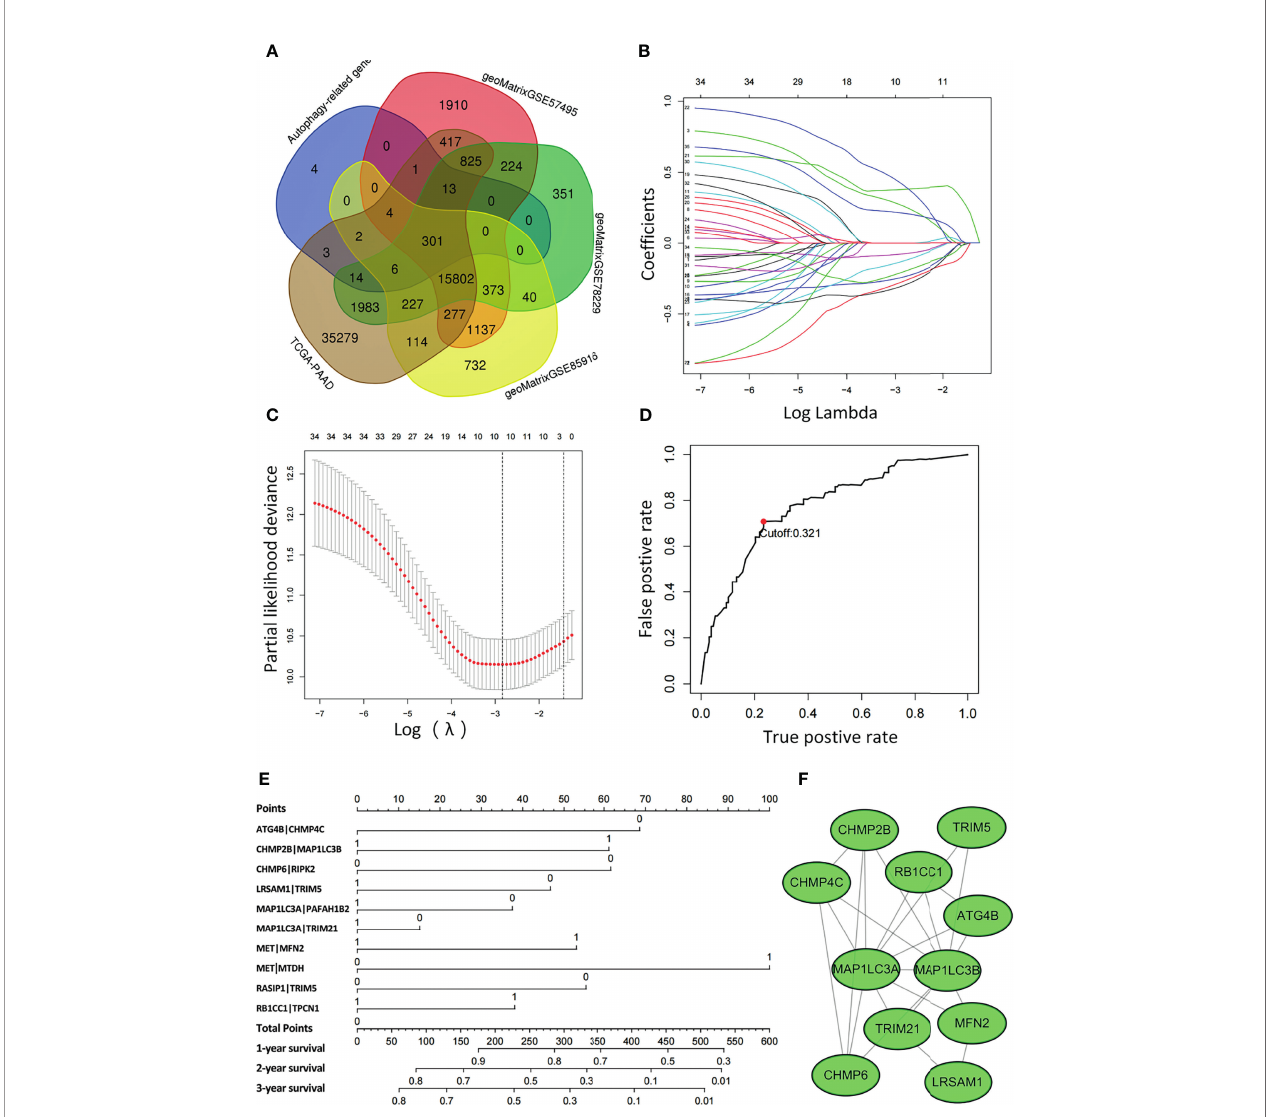
FIGURE 2 | Least absolute shrinkage and selection operator (LASSO) Cox regression analysis was conducted based on the autophagy-related signature. (A) Venn diagram showing the 301 ARGs screened in all fi ve cohorts. (B) Candidate ARGPs from the univariate Cox regression analysis were fi ltered by the LASSO algorithm. (C) LASSO coef fi cient pro fi les. (D) Time-dependent ROC curve of ARGPs in the TCGA-PAAD cohort (1-year AUC = 0.790, cutoff value=0.321). (E) Nomogram drawn to predict the 1-, 2-, and 3-year survival rates of pancreatic cancer patients. For a patient with ATG4B|CHMP4C=0, CHMP2B|MAP1LC3B=0, CHMP6| RIPK2 = 0, LRSAM1|TRIM5 = 0, MAP1LC3A|PAFAH1B2 = 0, MAP1LC3A|TRIM21 = 1, MET|MFN2 = 1, MET|MTDH=1, RASIP1|TRIM5 = 1, RB1CC1| TPCN1 = 1, the fi nal total scores are 68+0+61+46+37+0+53+100+0+37 = 402, corresponding to a 1-year survival rate of 60%, a 2-year survival rate of 15%, and a 3-year survival rate of 10%. (F) The ARGs constituting the model were mapped using Cytoscape